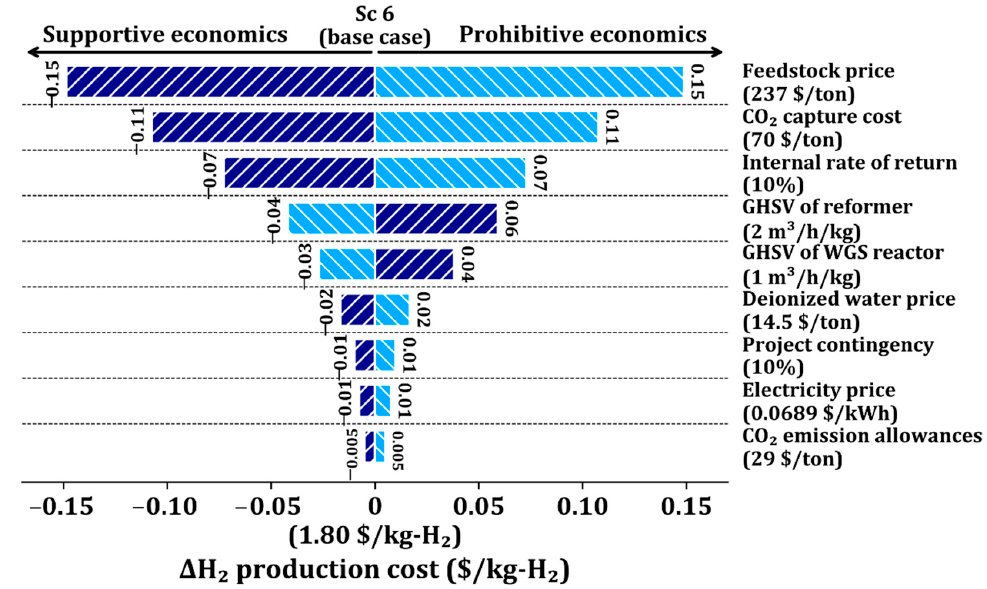
Figure 4. Sensitivity analysis of key economic parameters in Sc 6 using single-point tornado chart.